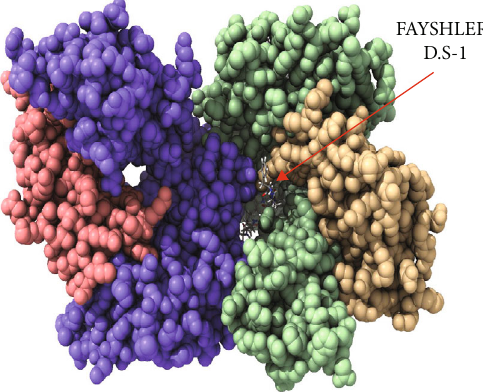
Figure 8: Molecular docking of FAYSHLERI peptide of Nipah virus docked in HLA-A ∗ 02:01 and visualized by UCSF Chimera X version 0.1.0. ∗ D.S: Docking Side No.1.